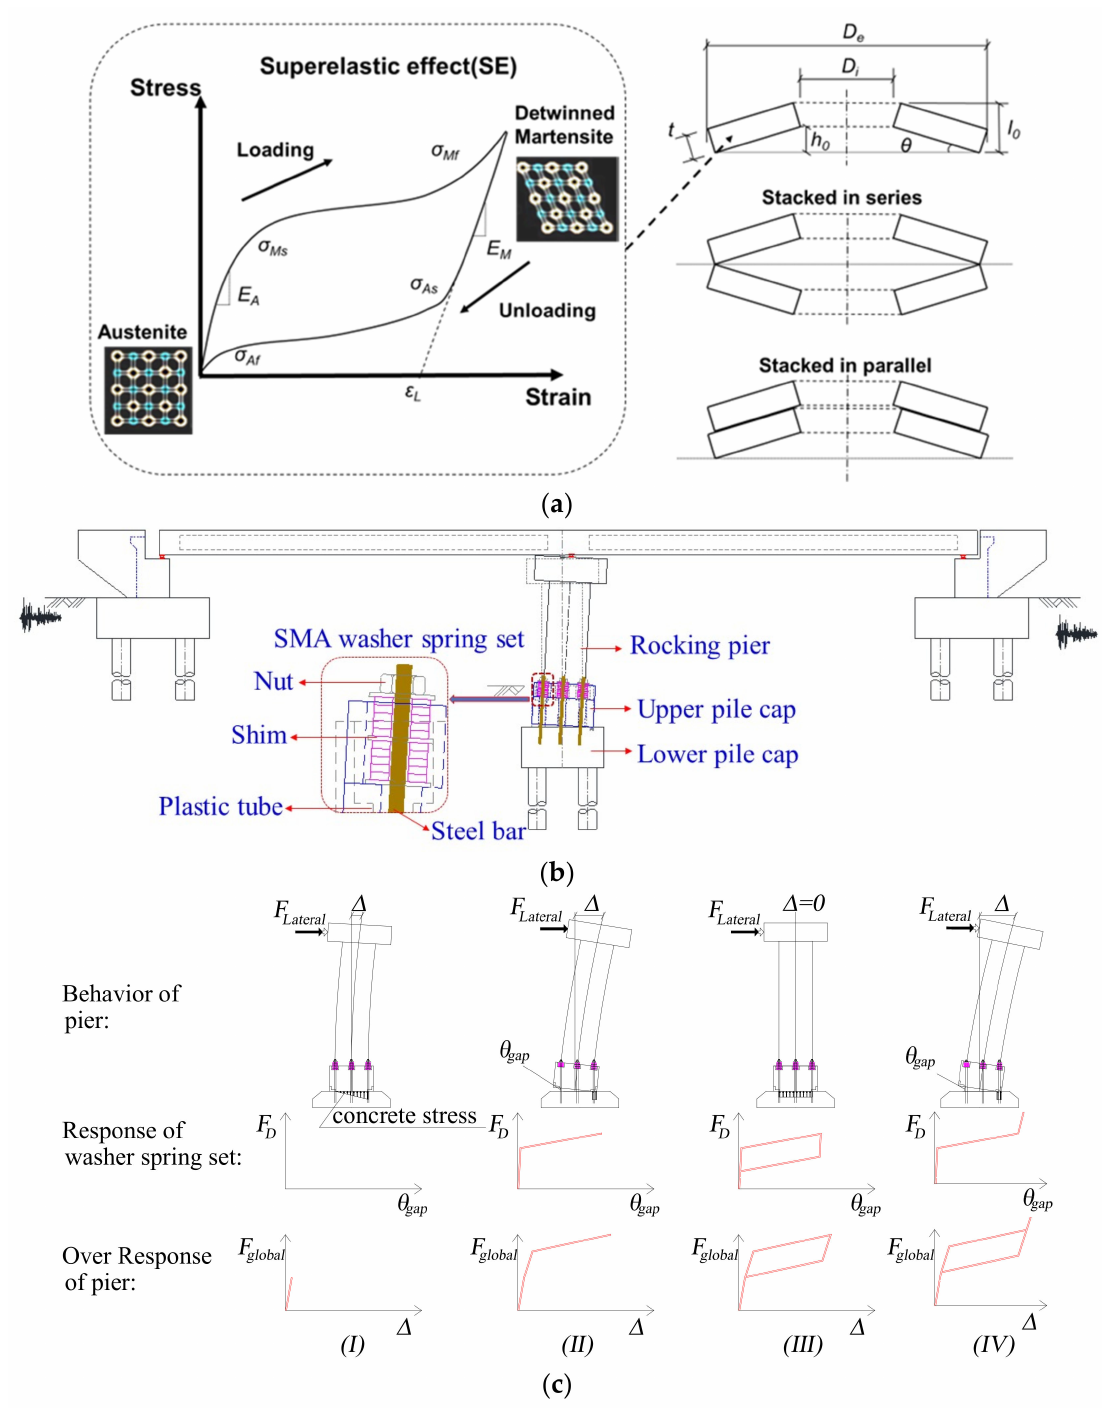
Figure 1. SMA-washer-based SCR bridge pier: ( a ) illustration of the SMA washer springs, ( b ) illustration of the bridge system, ( c ) working principle of the SCR bridge